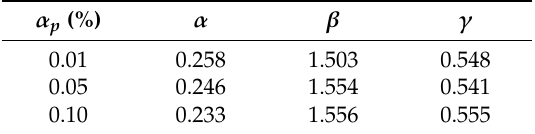
Table 3. Coe ffi cients of the fit Equation (8) to the R c